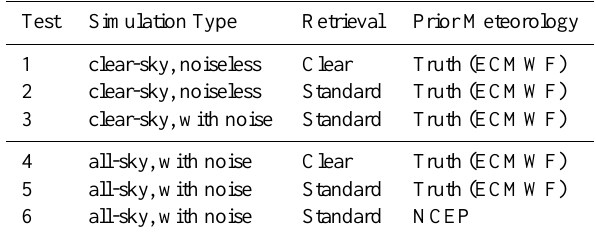
Table 5. Simulations and retrieval configurations used in this